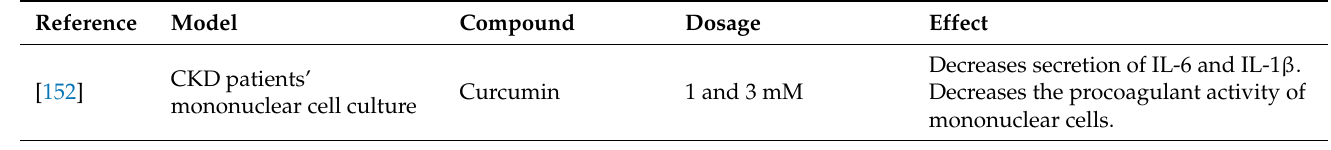
Table 2. Curcuminoids’ effects on CKD